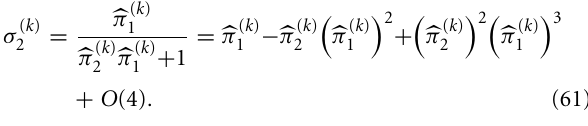
when observed uncertainty is less than predicted, the VOPE